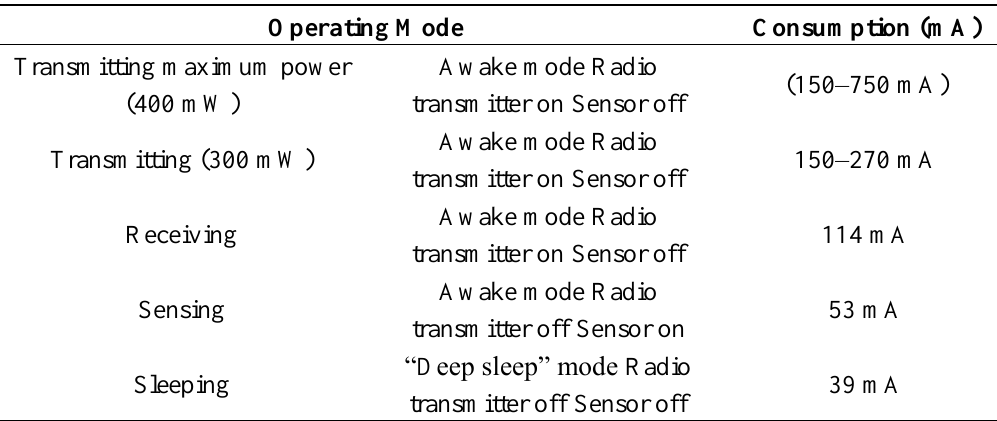
Table 5. Energy consumption in different operating